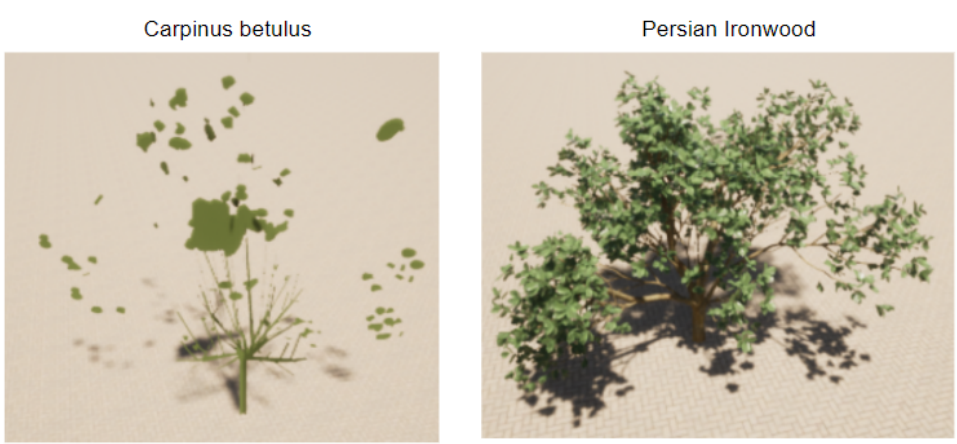
Figure A1. Example of tree equivalence by shape.